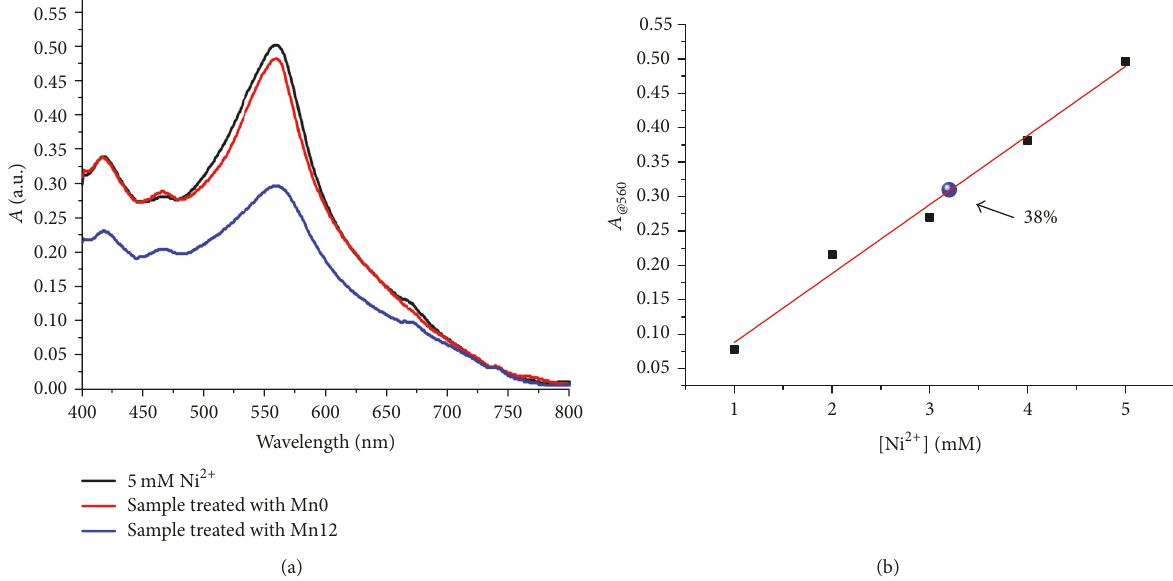
Figure 6: (a) Effect of the treatment carried out by Mn0 suspension (red line) and Mn12 suspension (blue line) evaluated by means of the dimethylglyoxime test. The black line represents the UV-visible spectrum of Ni 2+ /dimethylglyoxime complex at an ion concentration of 5 mM. (b) Absorbance intensity at 560 nm of the dimethylglyoxime-nickel complex as a function of nickel ion concentration. The blue circle represents the drastic decrease induced by the Mn12 (from a nickel concentration of 5 mM to 3.2